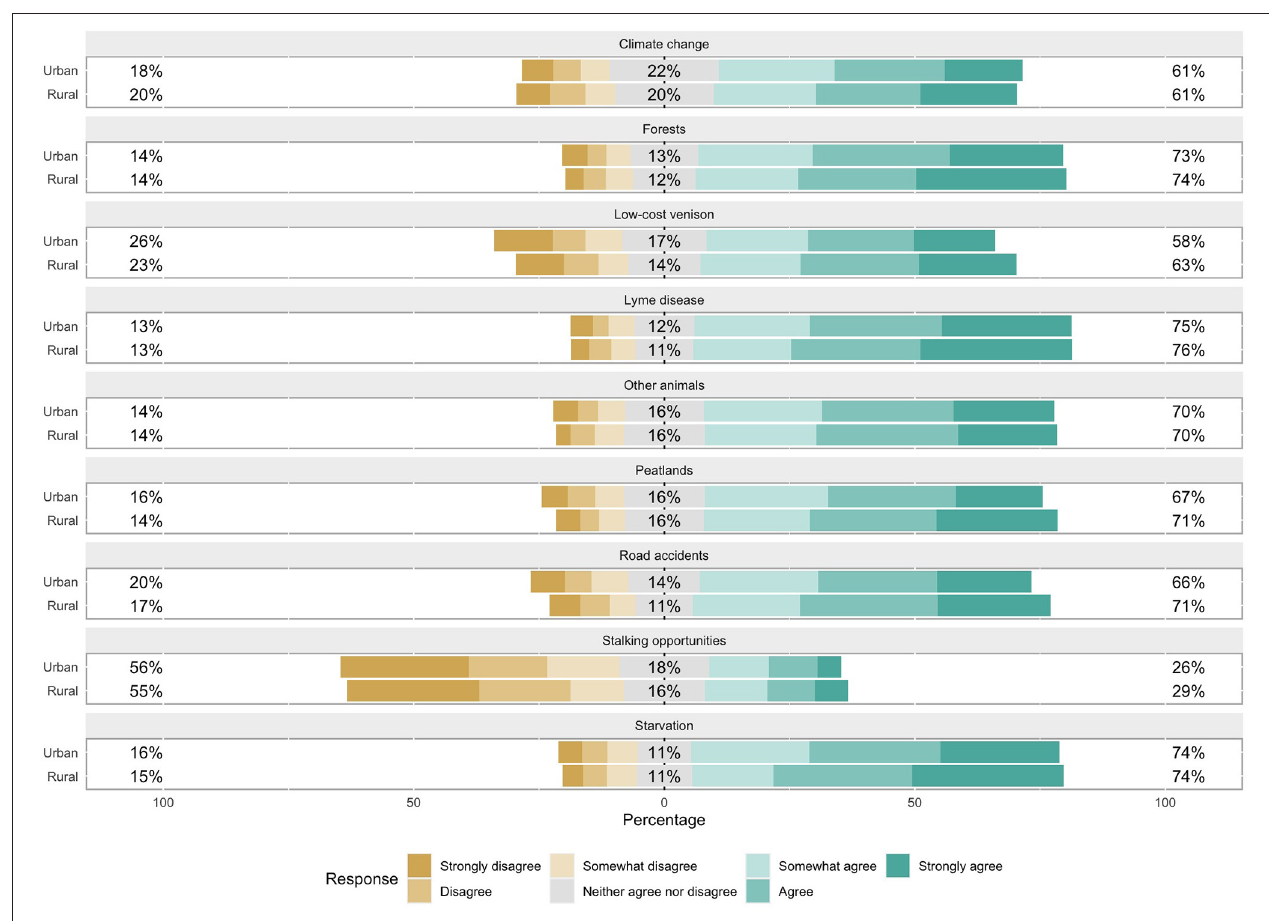
FIGURE 3 | Acceptability of shooting more deer if doing so would achieve various socioeconomic and environmental objectives, split by urban and rural respondents. Bars show distribution of responses, colored by disagreement (browns), indifference (gray), and agreement (greens). Percentages show proportions of respondents who disagreed (left), were indifferent (middle), or agreed (right) that it would be acceptable to shoot more deer if doing so would achieve each objective, after excluding “I don’t know”